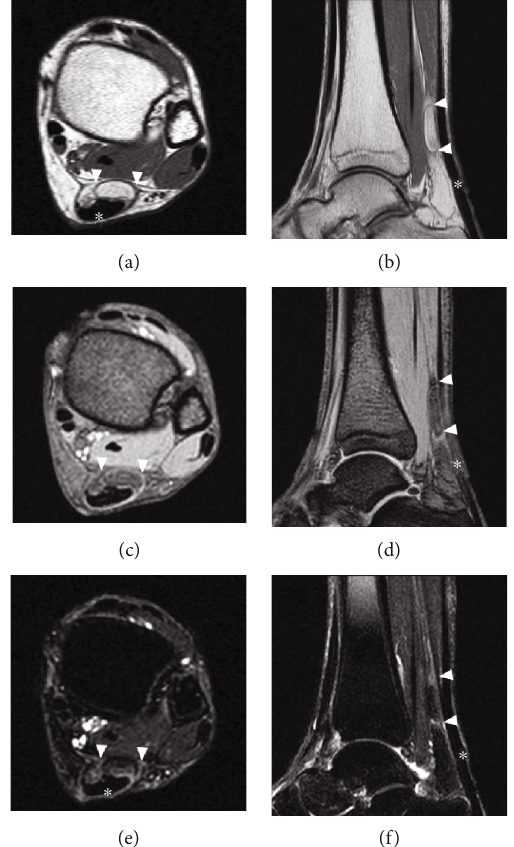
Figure 2: Magnetic resonance (MR) imaging at the second visit. Axial (a, c, and e) and sagittal (b, d, and f) images of T1WI, T2WI, and T2FS MR images. The second MR image shows that the lesion has migrated to the ventral aspect of the Achilles tendon. The location and shape of the lesion has changed compared with the previous fi ndings on the previous MRI, suggesting that the lesion was moving in and out around the Achilles